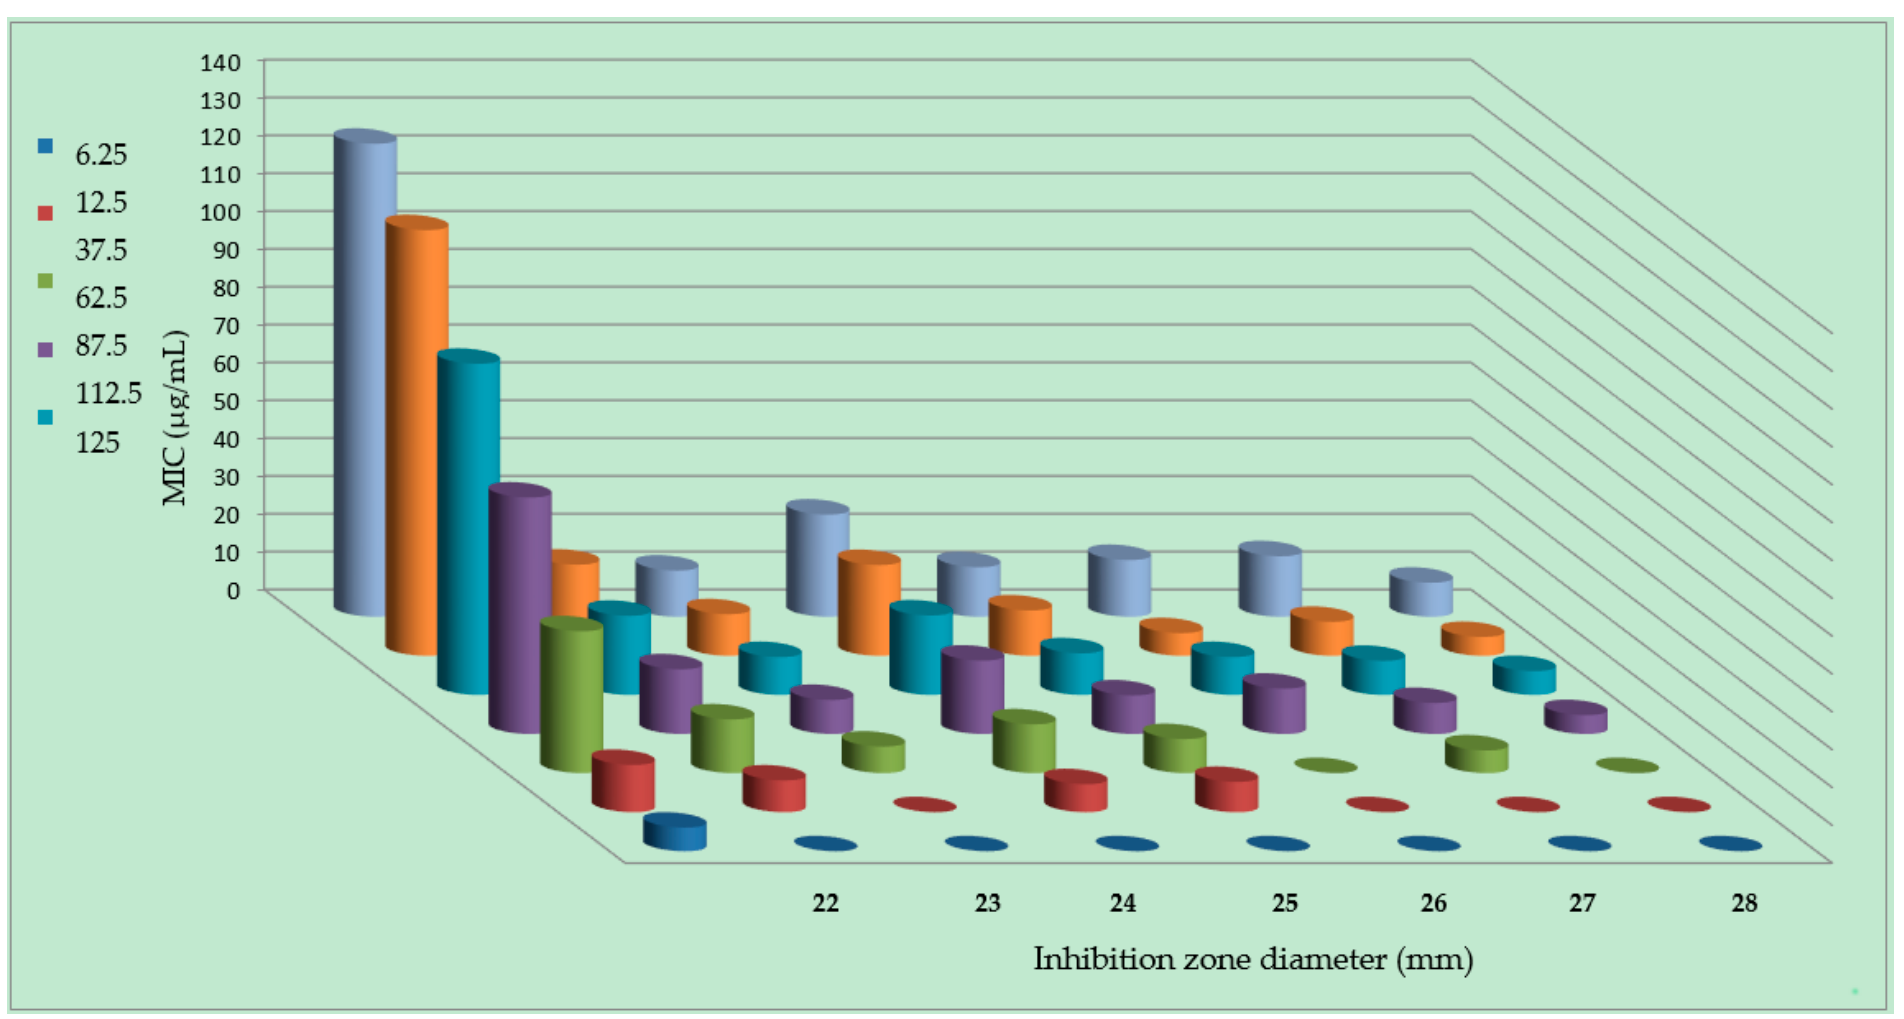
Figure 4. Antibacterial susceptibility of species P. mirabilis given as MICs values in µg/mL for compounds 22 – 28.